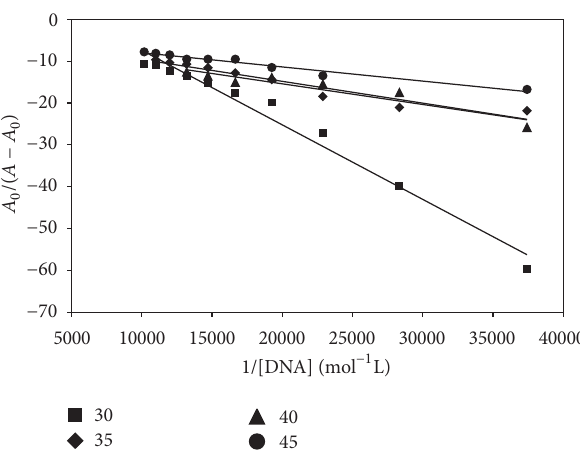
F 2: Typical plots of determination of the equilibrium binding constant (